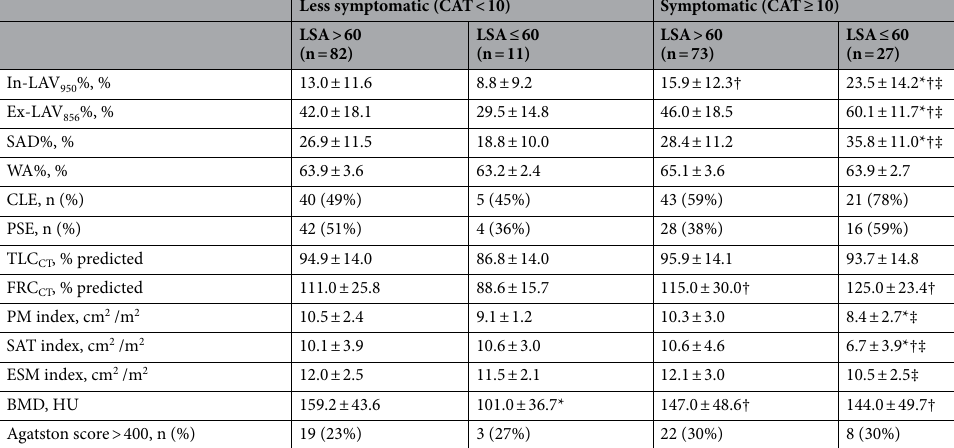
Table 3. Comparisons of computed tomographic findings between subgroups defined based on symptoms and physical activity questionnaires. Data are expressed as mean ± SD and n (%). Based on scores of COPD assessment test (CAT) and Life-Space Assessment (LSA) questionnaires, patients were divided into 4 groups. In-LAV 950 % = low attenuation volume percentage on inspiratory CT. Ex-LAV 856 % = low attenuation volume percentage on expiratory CT (air-trapping index). SAD% = non-emphysematous air-trapping percentage (small airway dysfunction) on inspiratory/expiratory CT. WA% = wall area percent. CLE = centrilobular emphysema. PSE = paraseptal emphysema. TLC CT = total lung volume on inspiratory CT adjusted by reference total